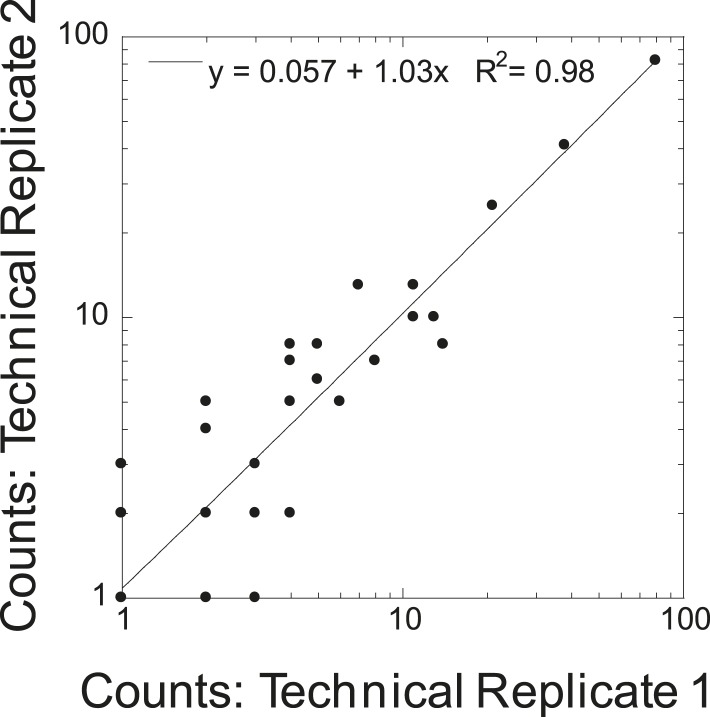
Cross correlation of technical replicates.Cross correlation of spectral counts for all protein identifications are shown for duplicate runs of STOMP analysis on human amyloid plaque material.